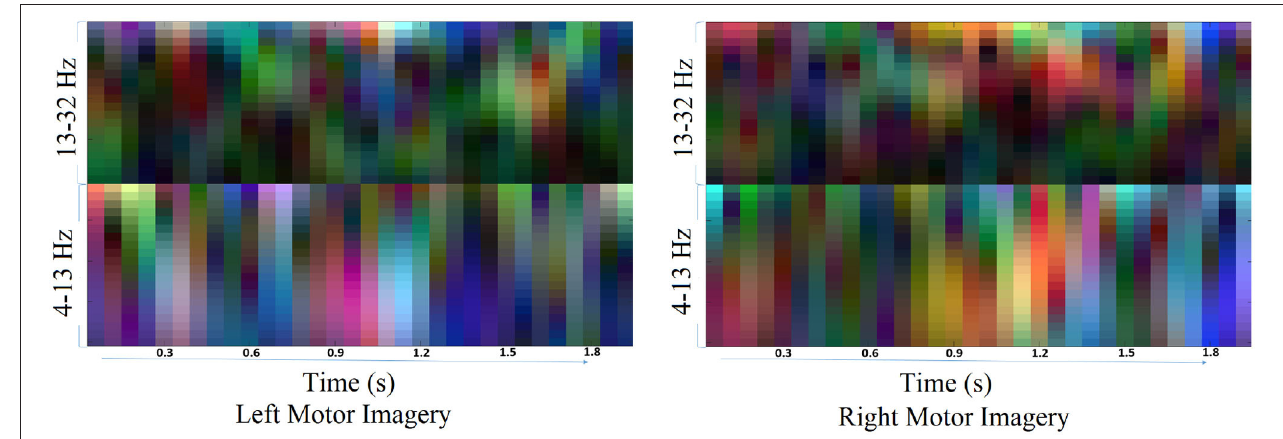
FIGURE 2 | Example of input images for left and right MI. The input images are formed by combining the theta-alpha and beta band STFT images vertically. The three EEG channels: C3, Cz, and C4, are stacked depthwise, the same as an RGB image. These images are then fed into the CNN for classification